Question: Identify the chart type used in this figure.
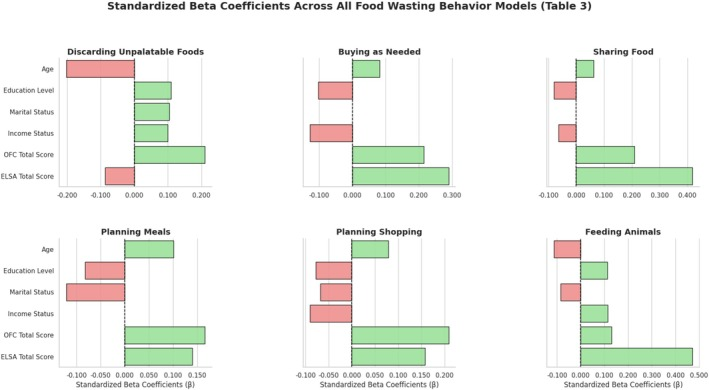
Answer: bar